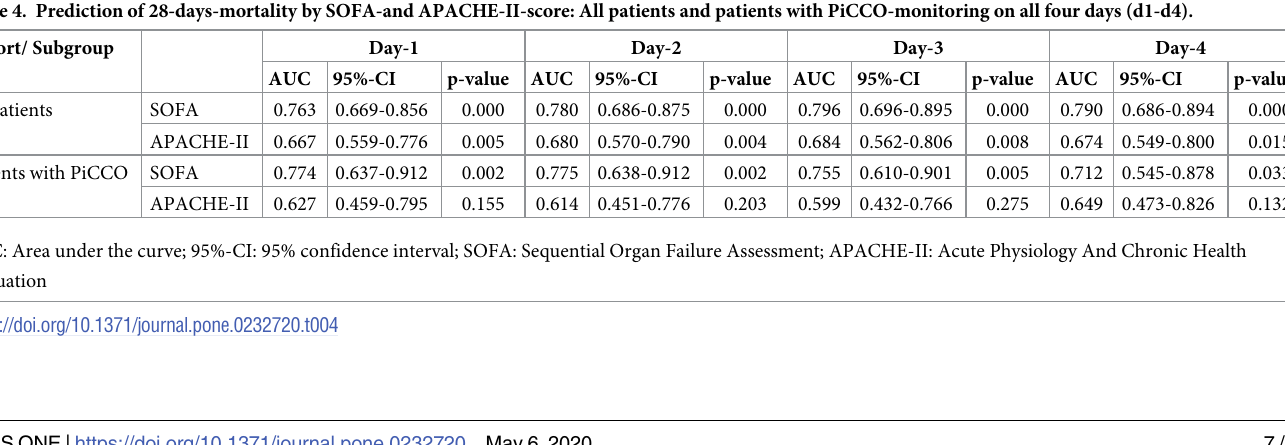
Table 3) predicted 28-days-mortality with significant p-values, but poor ROC-AUCs. AECC- definition and Murray_mod were not predictive. SOFA (AUC=0.780; p < 0.001; Table 4) predicted 28-days-mortality better than the APA- CHE-II (AUC=0.680; p=0.004). On day-3 and on day-4 none of the four ARDS-scores significantly predicted 28-days-mor- tality (Figs 3 and 4; Table 3). SOFA (AUC=0.796; p < 0.001) provided larger AUCs than APACHE-II (AUC=0.684; p=0.008) on day-3 and day-4 (AUC=0.790; p < 0.001 vs. AUC=0.674; p=0.015; Table 4). OI was the best predictor among the respiratory scores with a mean AUC of 0.625 (see Table 3), whereas the mean AUCs for all other scores were below the critical threshold of 0.6. Regarding the timing of prognosis , the best prediction of 28-days-mortality was found on day-1 (mean ROC-AUC=0.632) and day-2 (mean ROC-AUC=0.620; see Table 3), whereas mean ROC-AUCs were below 0.6 on day-3 and on day-4.